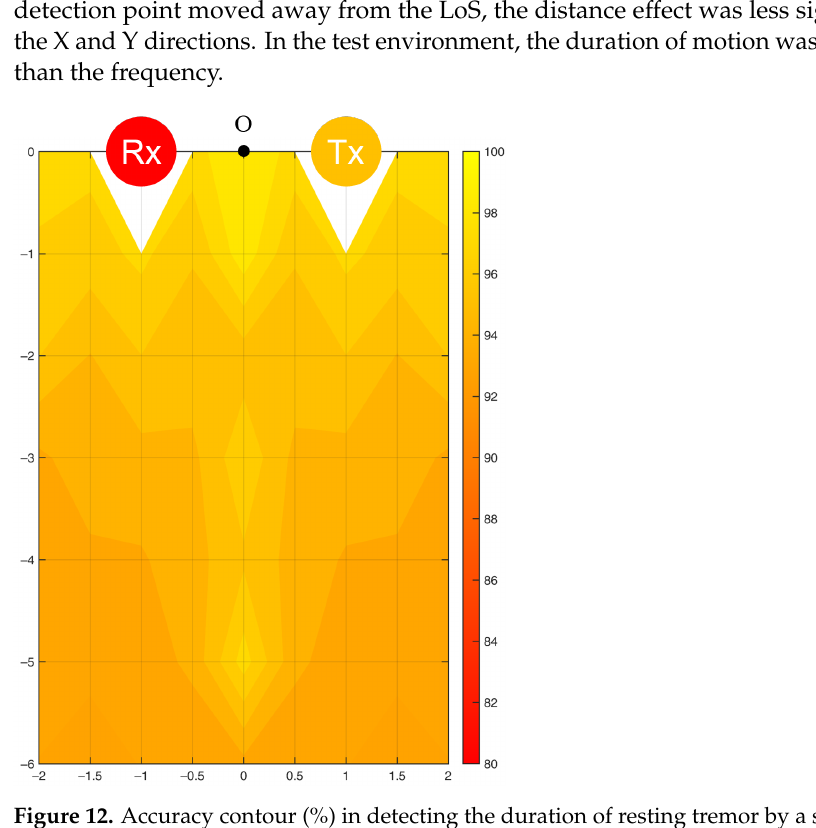
Figure 12. Accuracy contour (%) in detecting the duration of resting tremor by a single WiFi